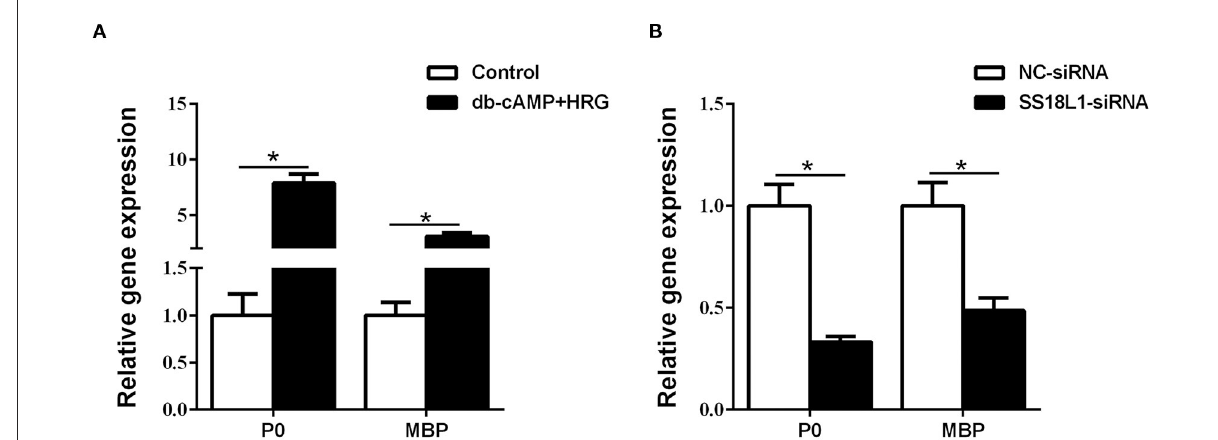
FIGURE6 The effect of SS18L1 on Schwann cell differentiation. (A) The mRNA levels of P0 and MBP were higher in Schwann cells cultured in differentiation culture medium (db-cAMP + HRG) than those cultured in control medium. (B) The mRNA levels of P0 and MBP were higher in siRNA control transfected Schwann cells cultured in differentiation culture medium than SS18L1 siRNA transfected Schwann cells cultured in differentiation culture medium. * P < 0.05, vs. siRNA